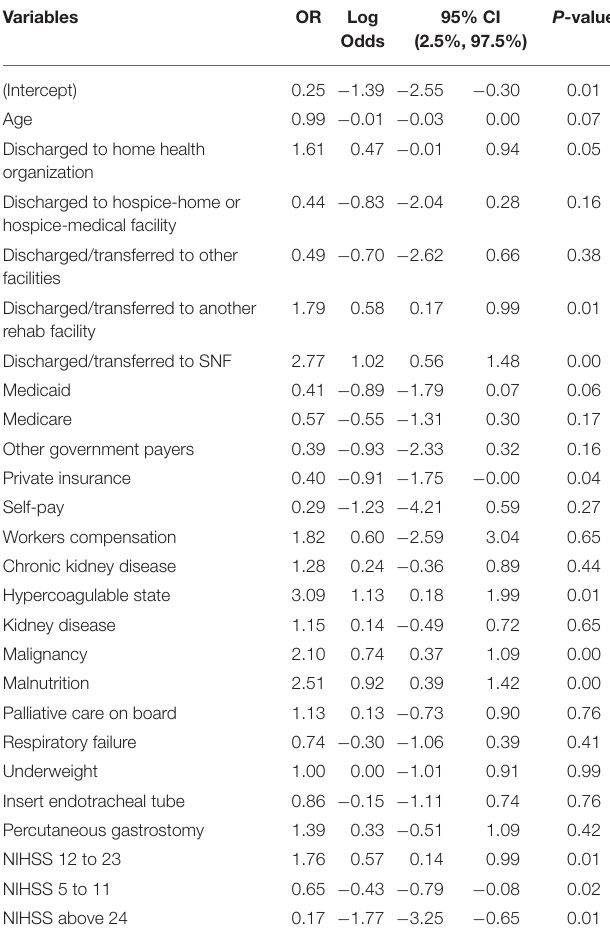
TABLE 4 | Logistic regression results for predictors of 30-day readmission in ischemic stroke patients (Design 3).